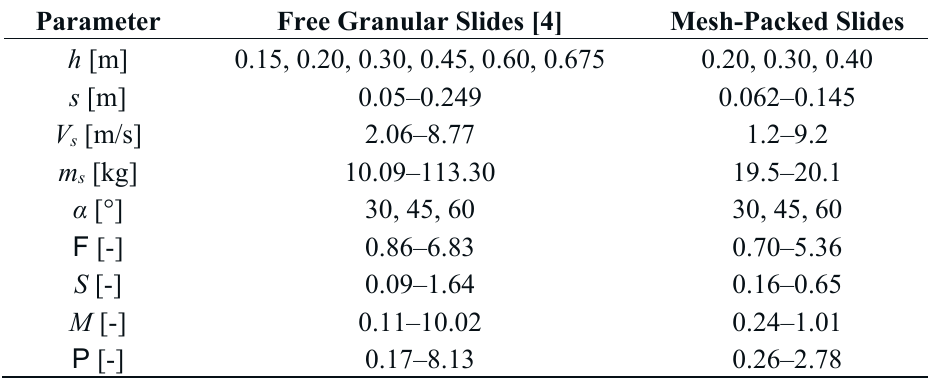
Figure 2. Capacitance Wave Gauge (CWG) 1–6 positions with Δ x 1 = 0.71 m and Δ x = 1.00 m for α = 30°; Δ x 1 = 1.13 m and Δ x = 1.00 m for α = 45°; Δ x 1 = 1.27 m and Δ x = 1.06 m for α = 60° (adapted from Heller [4], with permission from VAW). Table 1. Overview of experimental parameters and dimensionless